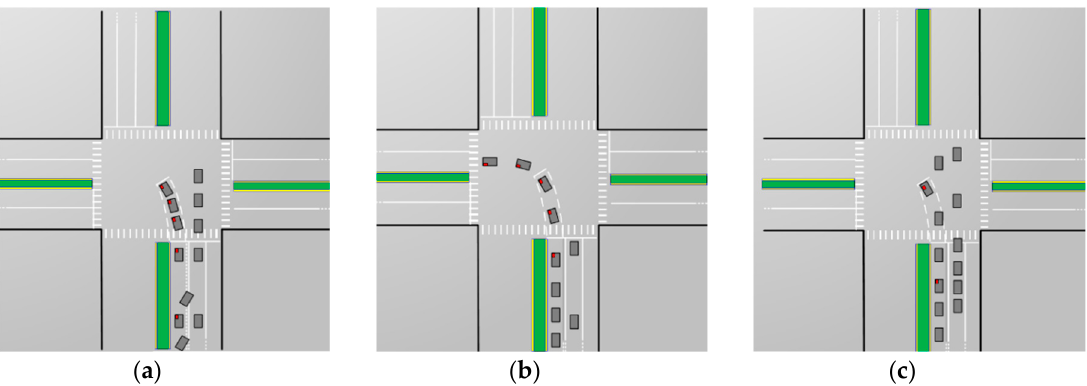
Figure 15. Vehicle movements diagram in shared lane and adjacent lane: ( a ) Unsaturated vehicle movements with the left-turn waiting area; ( b ) Filled vehicle movements with the left-turn waiting area; ( c ) Vehicle movements in left-turn green signal.